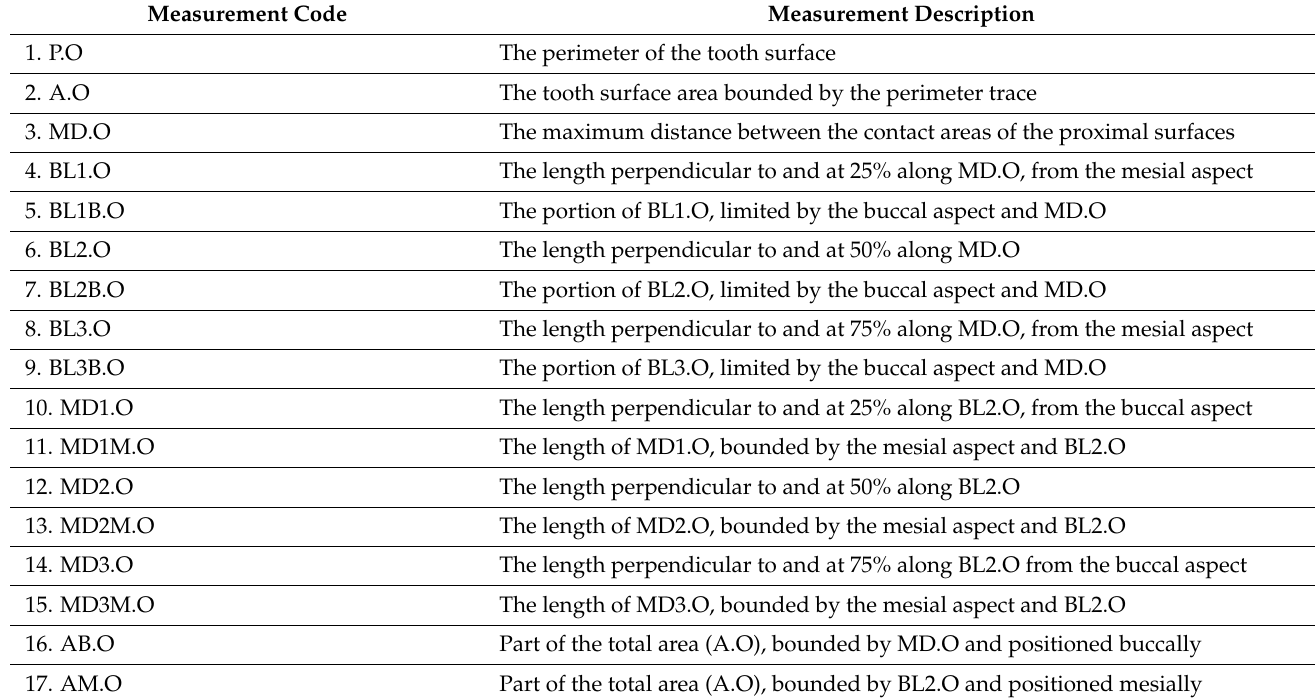
Table 2. Variables measured from the occlusal view of each tooth.